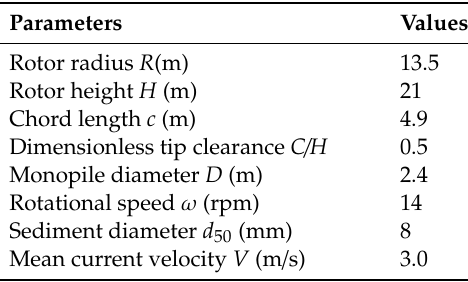
Table 5. Numerical setup of full-scale turbine model.